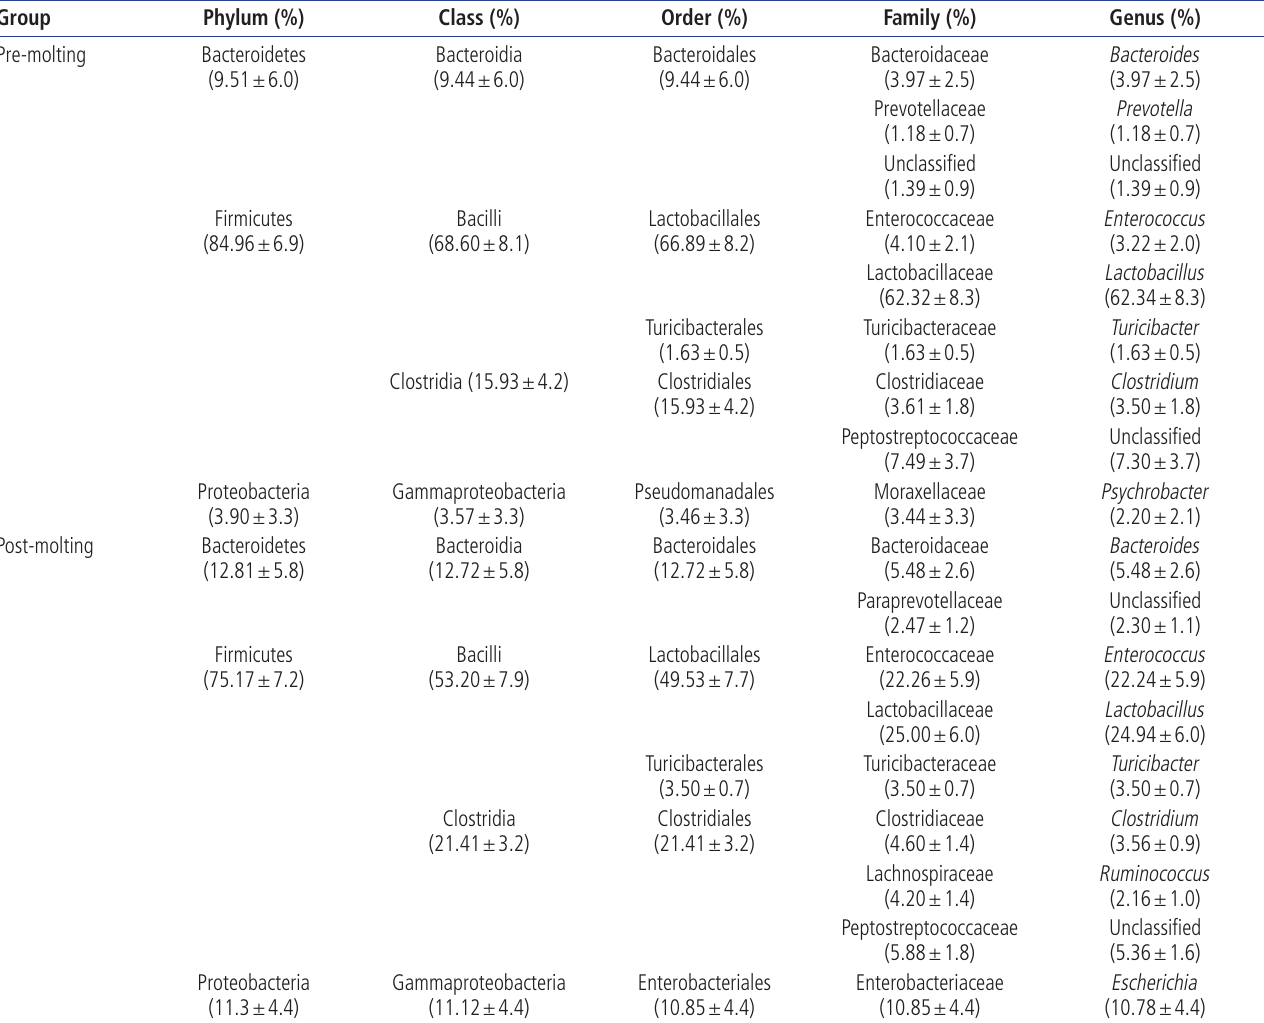
Table 1. Relative abundance 1) of top 9 bacterial taxa in the excreta between pre-molting and immediate post-molting